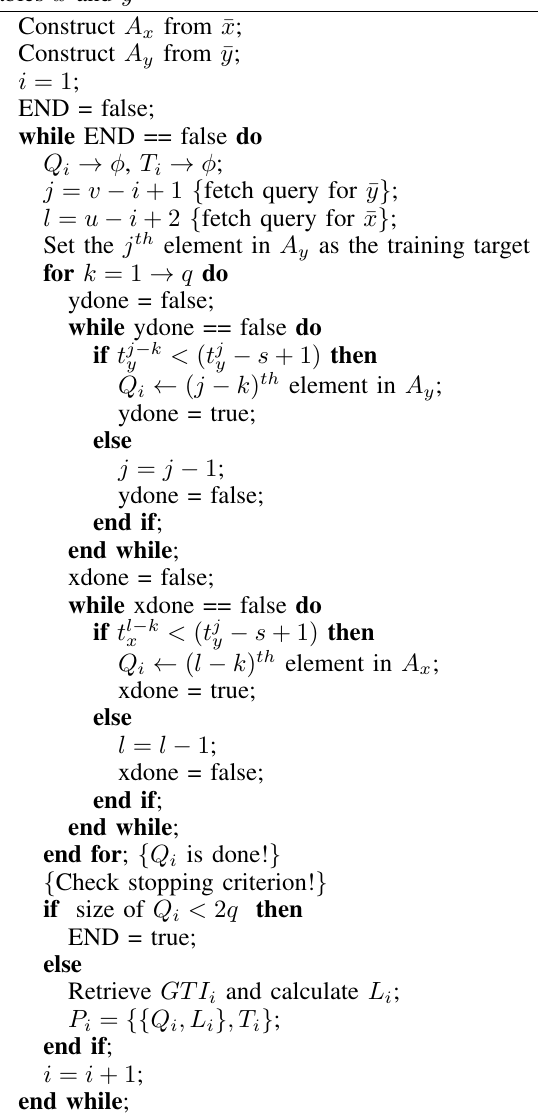
Algorithm 1 The algorithm of local time index with 2 vari- ables ¯ x and ¯